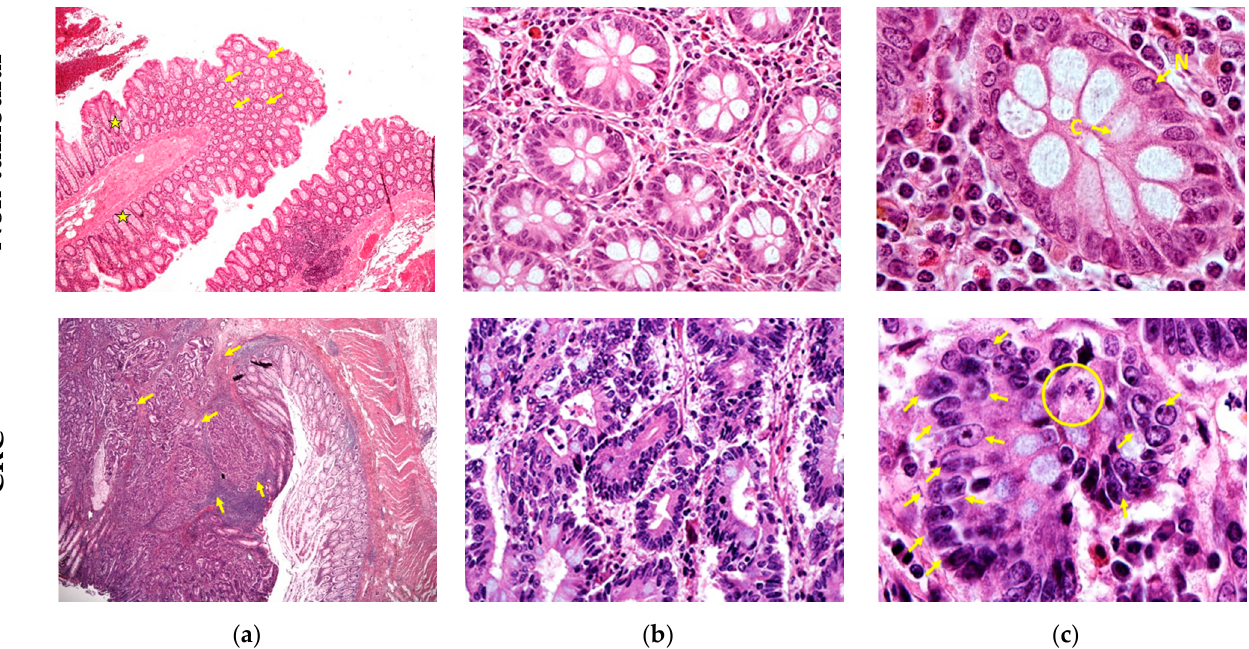
Figure 1. Histological inspection. Haematoxylin and eosin-stained representative regions of one out of four patients under study. Upper panel, non-tumoural adjacent colon shows the typical architecture with roundish (arrows) or elongated (stars) evenly spaced glandular structures lined by mucus secreting cells ( a , b ). In the lower panel, colorectal cancer presents crowded glands showing a cribriform or back-to-back growth pattern (arrows) ( a , b ). At higher magnification, normal gland shows a single layer of polarised cells with basal nuclei (N) and large cytoplasm (C) facing the lumen ( c ). Neoplastic glands show crowded enlarged nuclei (arrows) with prominent nucleolus and reduced cytoplasm. A mitotic figure is also present (see encircled nucleus) ( c ). The images were acquired at 40× ( a ) 400× ( b ) 1000× ( c ) magnification.